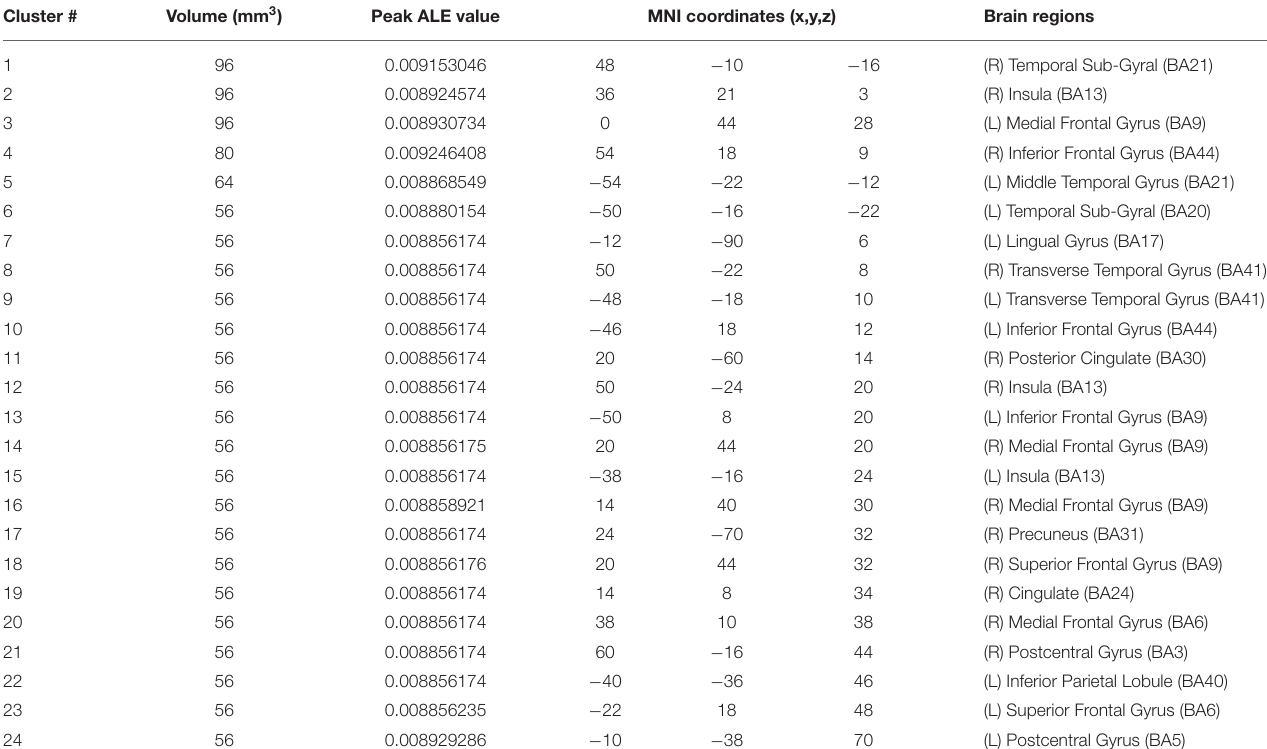
TABLE 2 | Results of ALE analyses on gray matter reduction in SCZ. Cluster